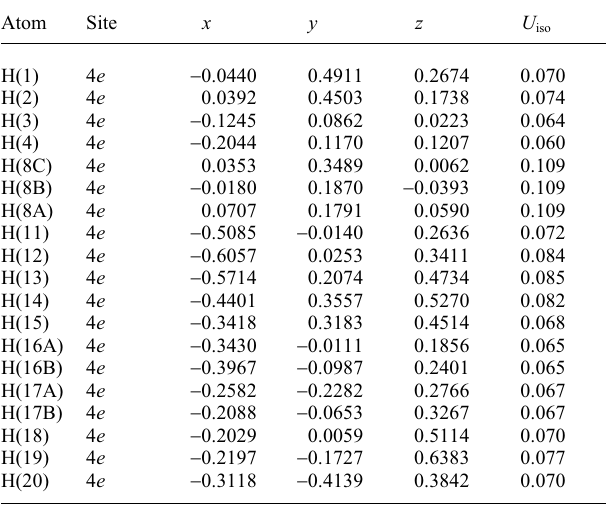
Table 2. Atomic coordinates and displacement parameters (in Å 2 )